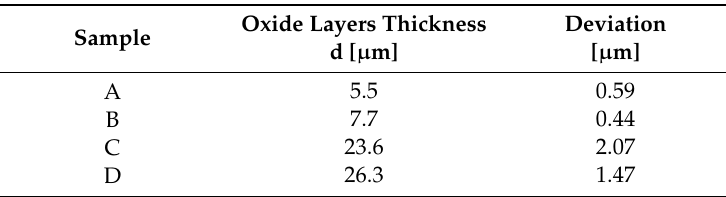
Table 3. Influence of anodizing conditions on thickness of oxide layers formed on EN AW-5251 aluminum alloy